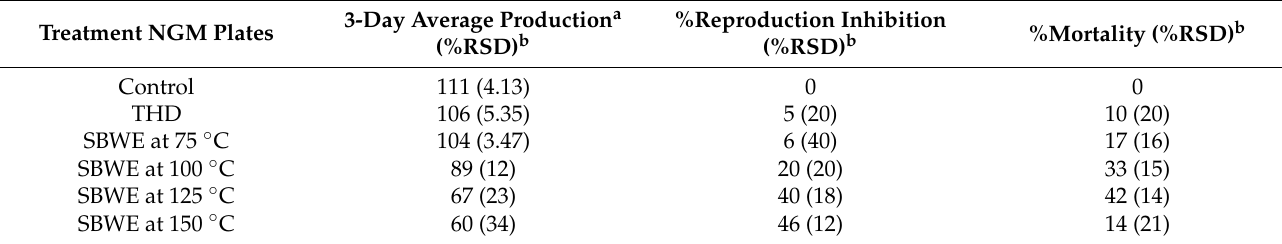
Table 3. Percentage reproduction inhibition and mortality of Caenorhabditis elegans after 30 h exposure to the 10 times diluted traditional herbal decoction and subcritical water extractions of Salvia miltiorrhiza at 75 to 150 ◦ C. Treatment NGM